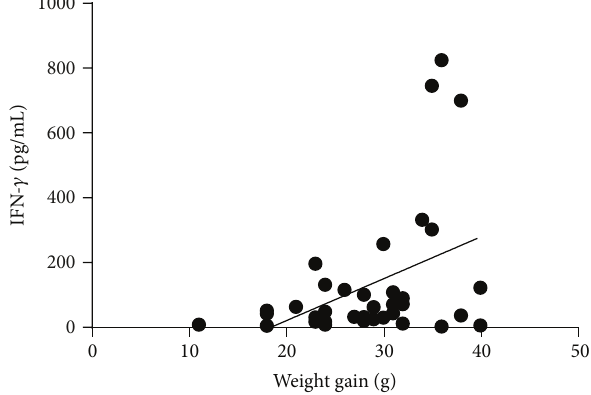
Figure 2: The level of the inflammatory cytokine IFN- 𝛾 increased with weight gain ( 𝑃 < 0.01 , correlation factor